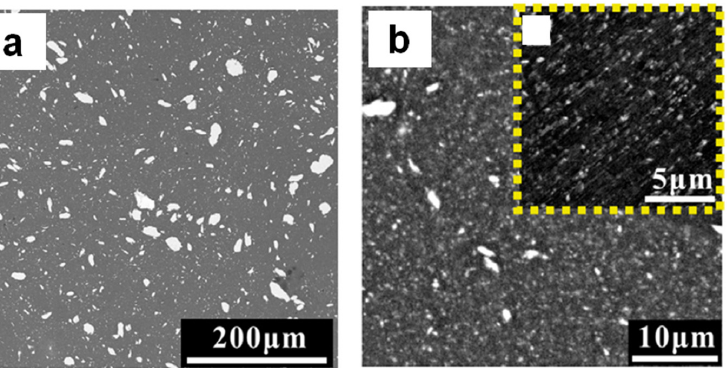
Figure 15. Microstructure of the hot-extruded composites obtained from Al 7075 + 8 vol.% Ti 52 Cu 20 Ni 17 Al 11 mixtures milled for 10 h ( a ) and 50 h ( b ). Reprinted from [67], Copyright (2018), with permission from Elsevier.